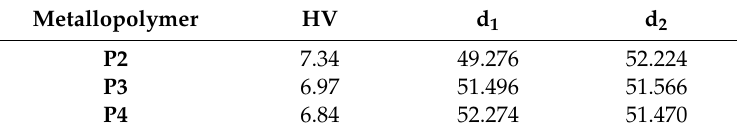
Table 3. Summary of Vickers hardnesses of metallopolymers P2 to P4